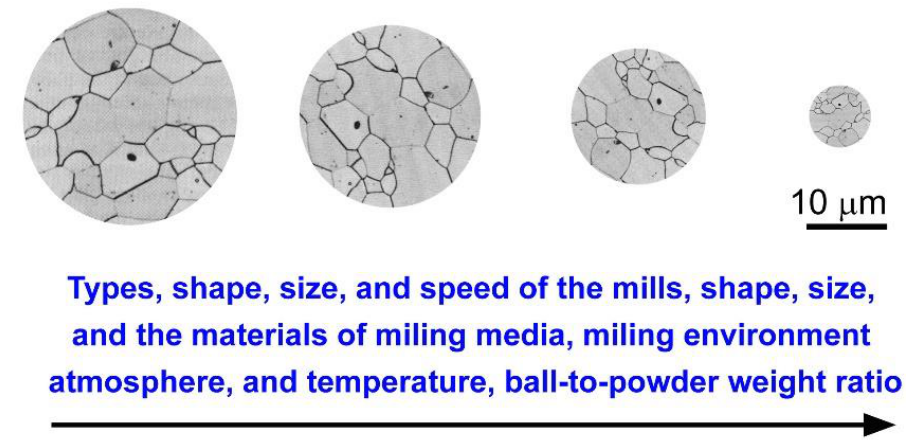
Figure 7. Factors impacting the milling process and affecting the particle size distribution of the